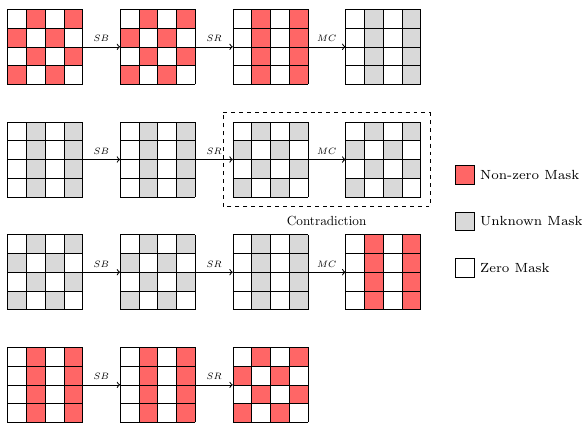
Figure 10: Zero-correlation distinguisher for AES 4